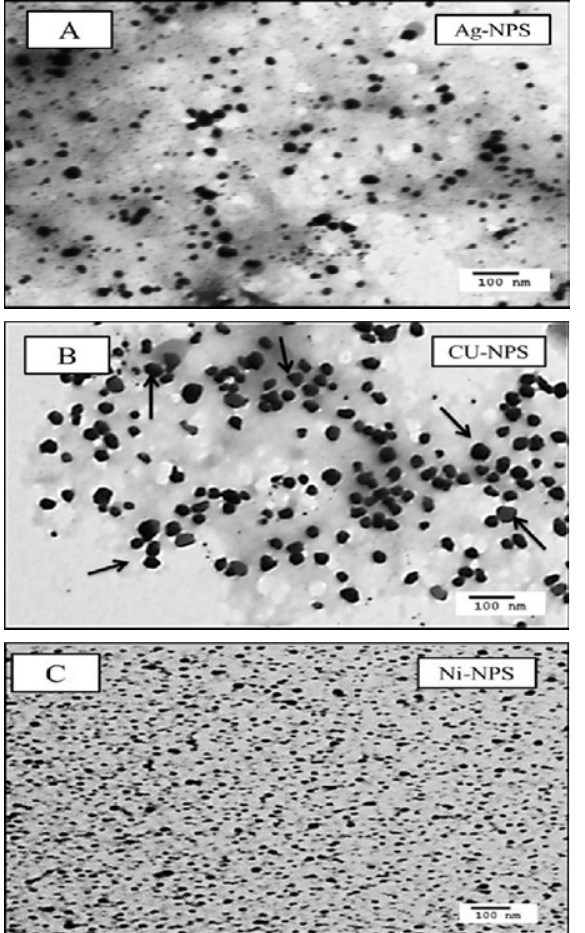
Fig. 3. TEM analysis for Ag-NPS, CU-NPS, Ni-NPS, synthesized by